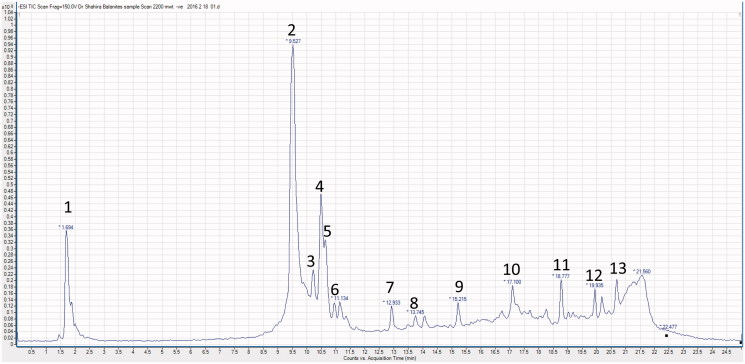
A representative UPLC-negative ionization MS trace of the 70% ethanol extract of B. aegyptiaca (BE).